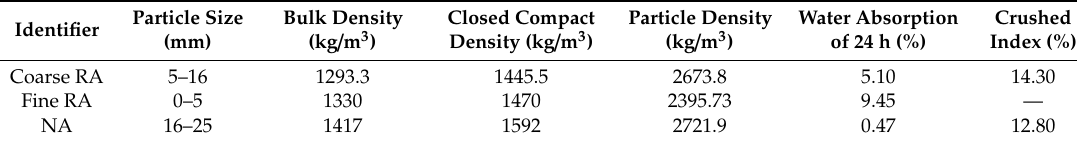
Table 1. Basic properties of recycled and natural aggregates.